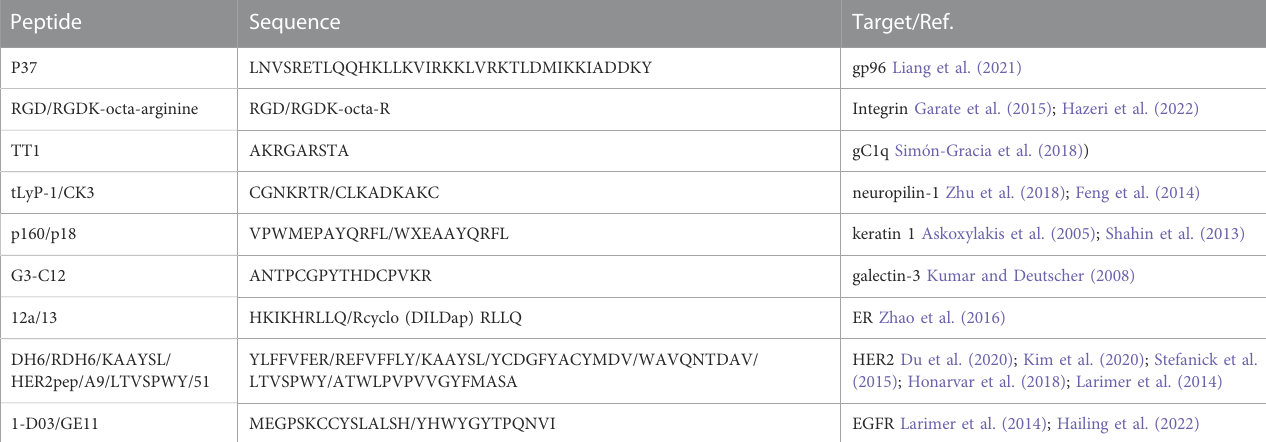
TABLE 1 Summary of the major peptides against breast cancer with respective targets. Peptide Sequence